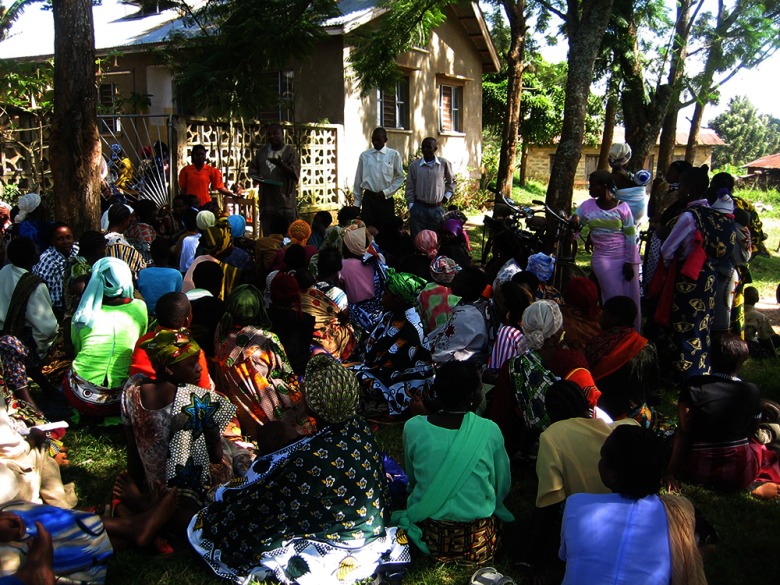
Health facility staff discuss family planning options with women waiting for outreach services in northern Tanzania. © 2016 EngenderHealth